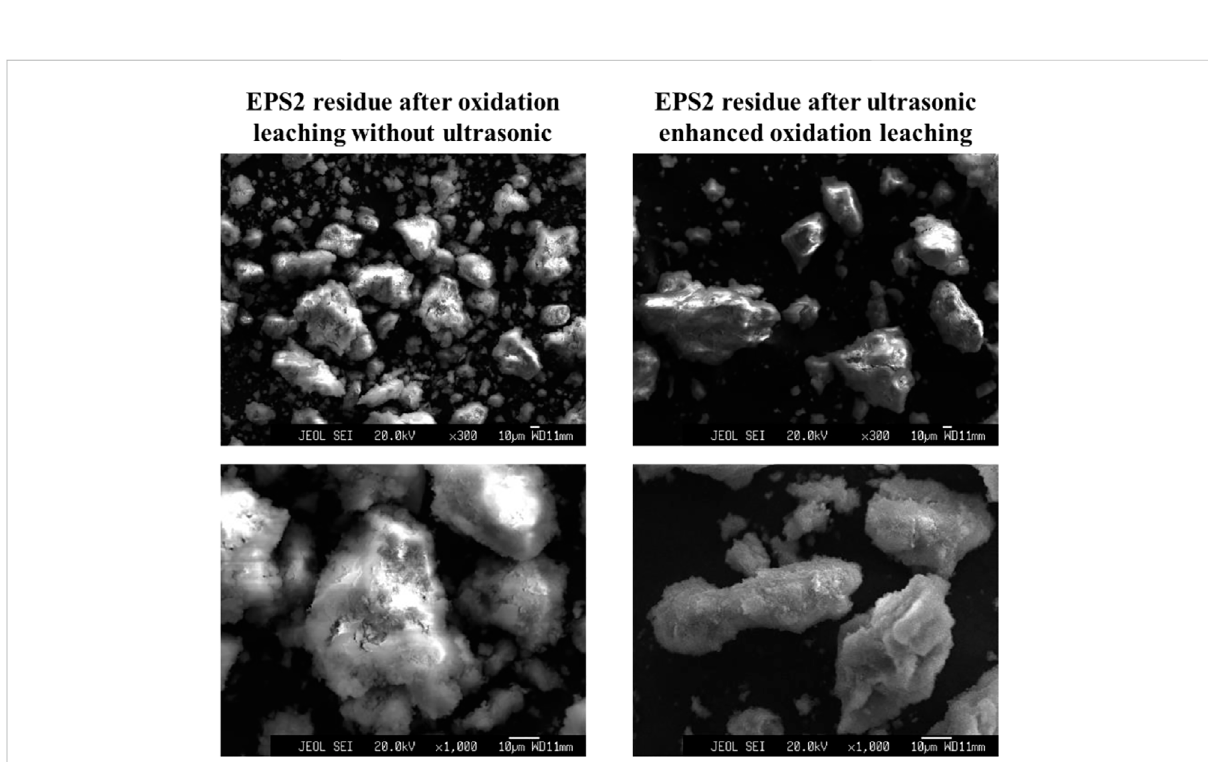
FIGURE 12 Particle morphology of complex sludge (EPS2) after oxidation leaching with and without ultrasonic treatment.